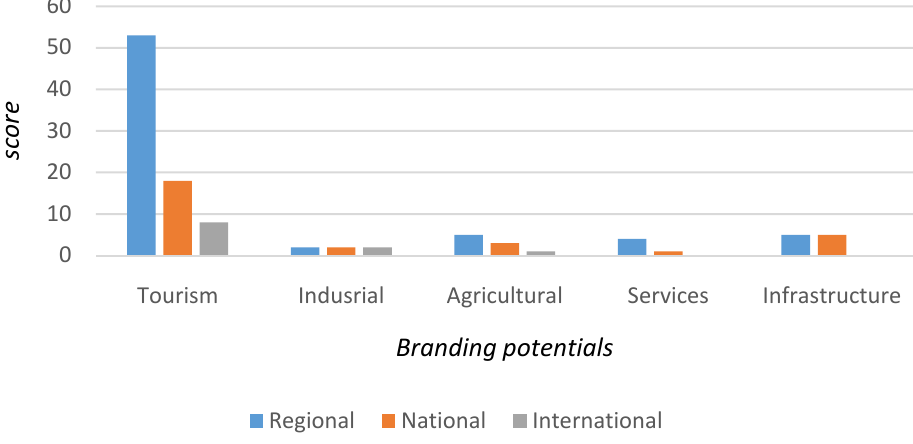
Fig.4. The spatial level of branding potential in Qazvin urban agglomeration Table 1. The selected potential for branding plan of Qazvin urban